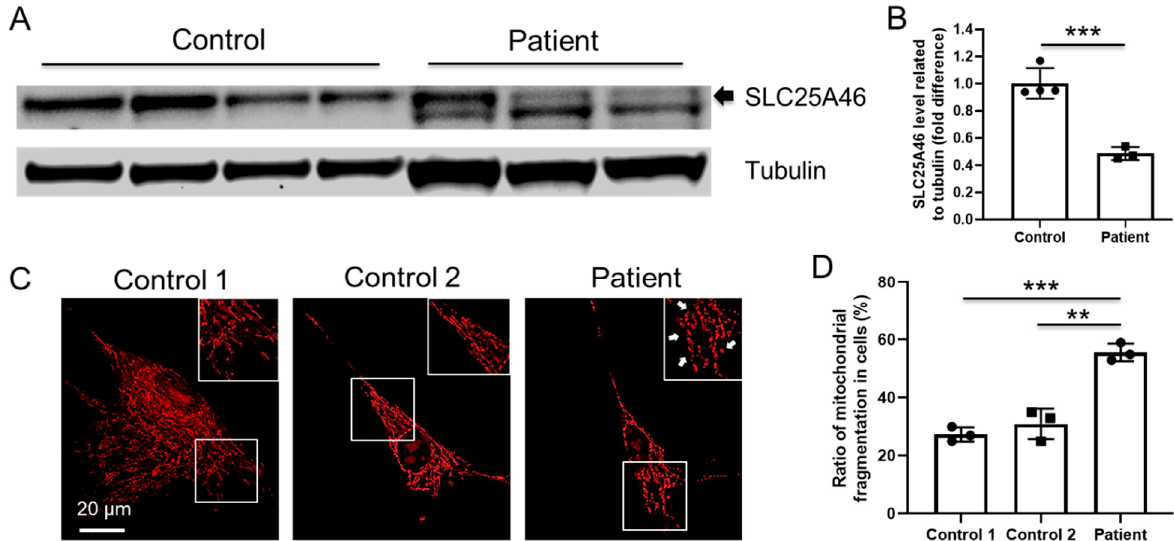
Figure 2. ( A ) Immunoblot analysis of total cell lysate from proband and two control fibroblasts using antibodies against SLC25A46 (46 kDa) and tubulin (55 kDa) as loading control. ( B ) Quantification of protein levels normalized to tubulin, *** p < 0.001. ( C ) Representative immunostaining images of Mitotracker (red) staining in control and proband fibroblasts. Insert plot is the magnified figure indicated by the white square. Arrow indicates the mitochondrial fragmentation in the proband cells. Scale bar=20 um. ( D ) Quantification of the mitochondrial fragmentation in fibroblast cells (** p < 0.001, *** p < 0.001, each group counts over 50 cells), compared to control.